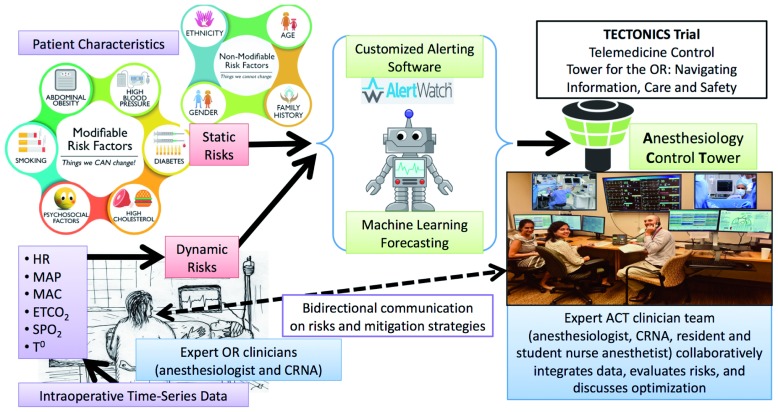
The key workflow and process components of TECTONICS.The team in the ACT receives data form the electronic health record, web-interfaced monitors in the operating room (OR), video cameras in the OR, multipath convolutional neural network machine learning algorithms, and alerting software has been customized to provide maximum utility in an ACT. The team weaves together disparate data strands, and collaboratively formulates a plan to address the patient’s risk and optimize outcomes. The plan is discussed collegially with OR clinicians, who exercise judgement in delivering the best individualized perioperative management to each surgical patient. Dynamic data from OR patient monitors. (The photo was taken in our prototype ACT). CRNA, certified registered nurse anesthetist.